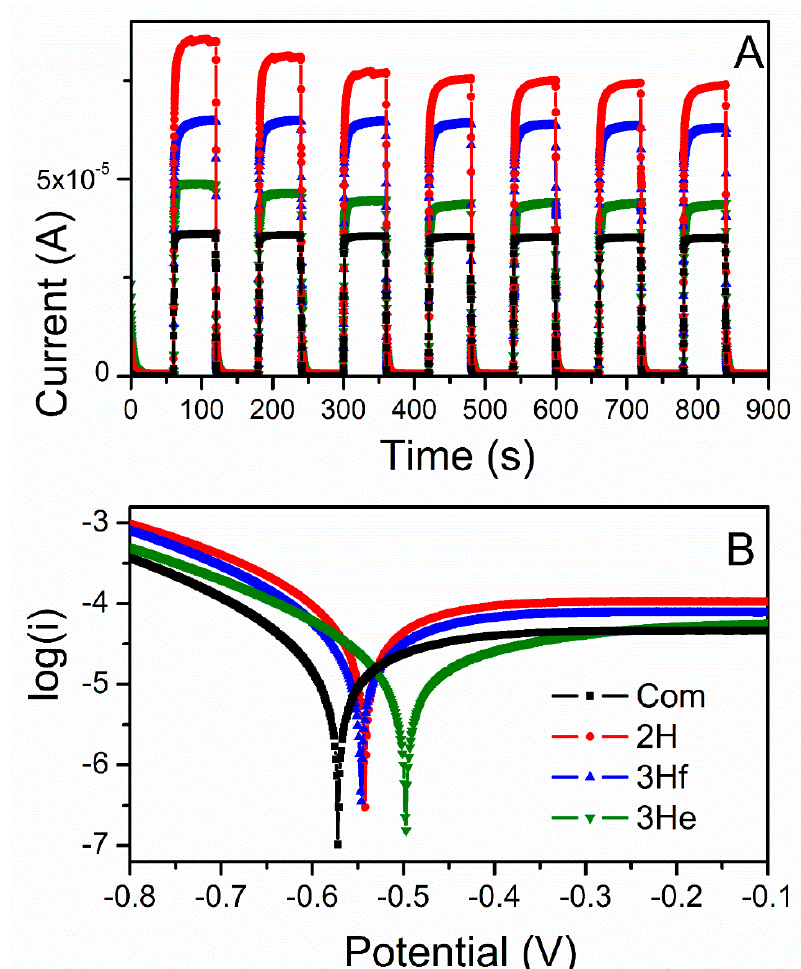
Figure 6. Photocurrent response under dark and illuminated conditions recorded at open circuit potential ( A ), and Tafel plots generated from linear sweep voltammograms under illumination ( B ).